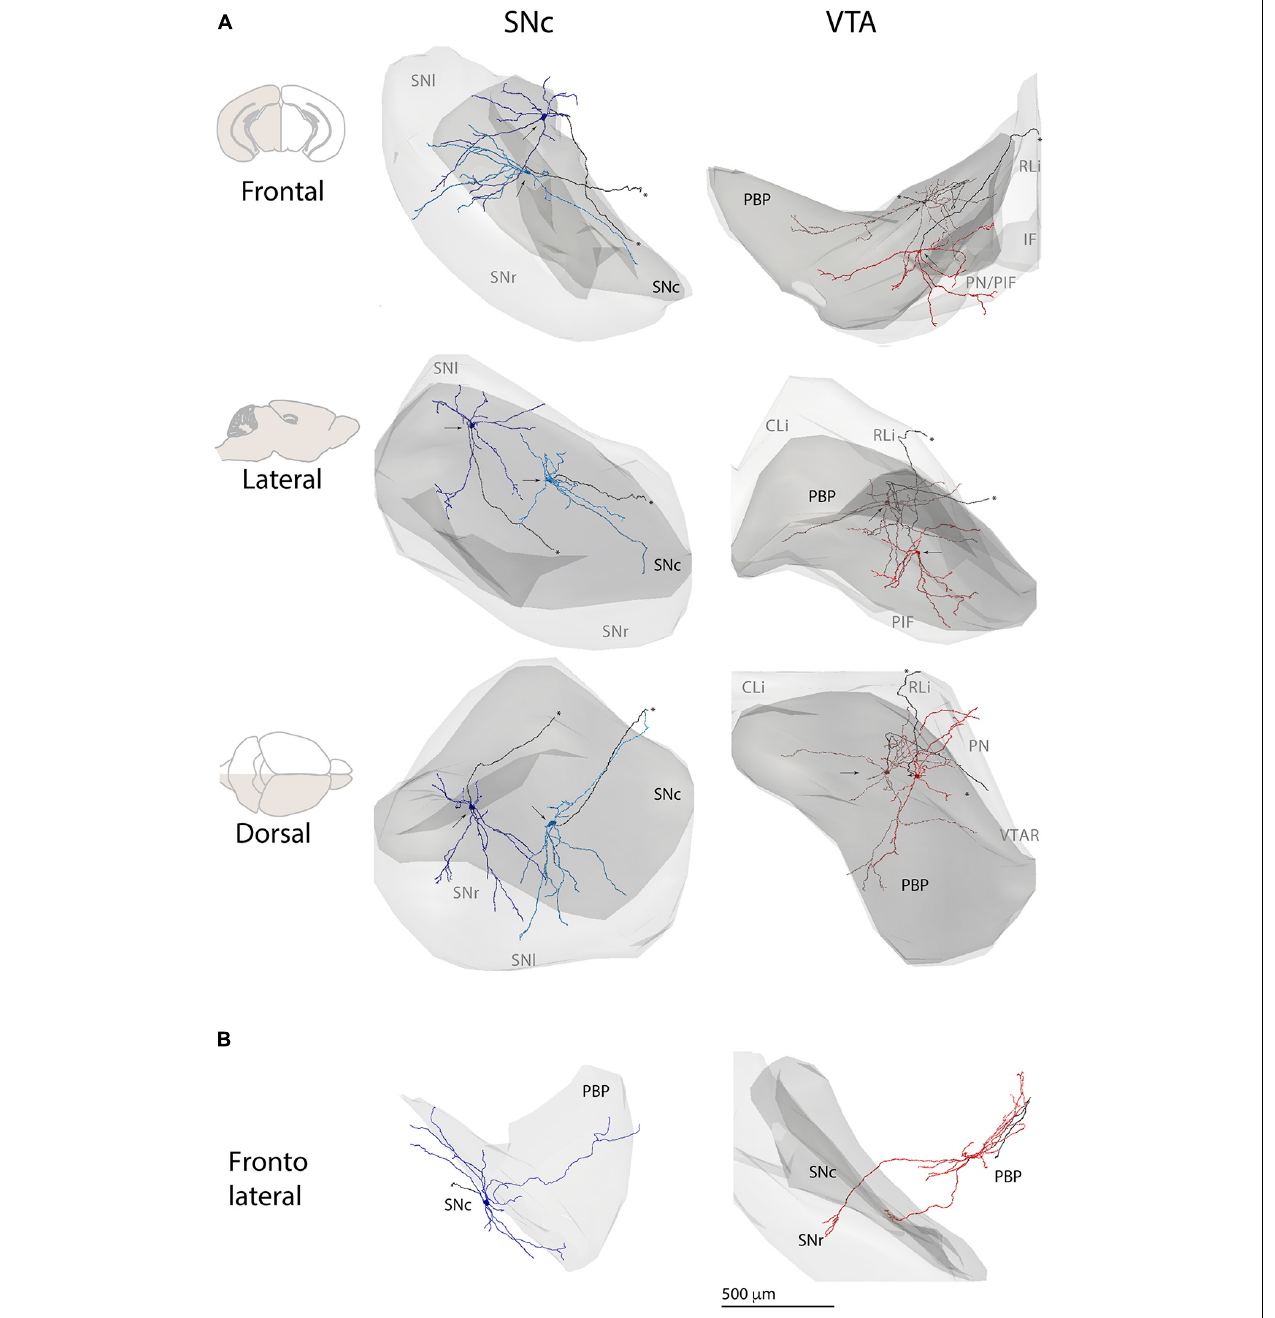
FIGURE 3 | Cell body and dendritic domain of individual substantia nigra and VTA neurons within and between respective regions. (A) 3D reconstructions of two SNc (left column) and two VTA (right column) DA neurons and respective regions. Neurons were placed inside 3D renderings of substantia nigra and VTA, as part of a common reference map based on Fu et al. (2012). Depicted in light gray is the substantia nigra (left) or the VTA (right) and in darker gray is the SNc or PBP. Gray text indicates the projected location of SN or VTA subdivisions. Arrows indicate the position of cell bodies. Axons are in black and marked with an ∗ . For SNc DA neurons, note the extension of dendrites outside the boundaries of SNc into the SNr (frontal and dorsal views). For the VTA DA neuron depicted in bright red, note the extension of dendrites outside the boundaries of the PBP, into more ventral VTA subdivisions PIF and PN (frontal and dorsal views). (B) 3D reconstructions of one SNc (left) and one VTA DA neurons (right) depicting dendritic extensions onto PBP and SN, respectively. Only PBP (left) and SNc-SNr (right) contours are shown. CLi, caudal Linear nucleus; IF, interfascicular nucleus; PBP, parabrachial pigmented nucleus; PIF, parainterfascicular nucleus; PN, paranigral nucleus; RLi, rostral linear nucleus; SN, substantia nigra; SNc, substantia nigra pars compacta; SNl, substantia nigra compacta pars lateralis; SNr, substantia nigra pars reticulata; VTAR, rostral VTA.